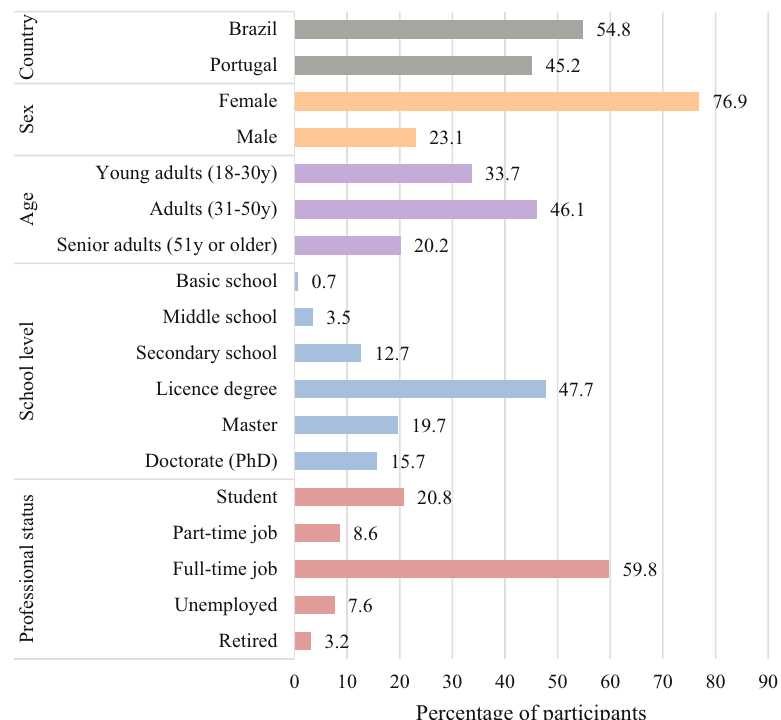
Figure 1: Sociodemographic characterisation of the sample ( N = 694 )